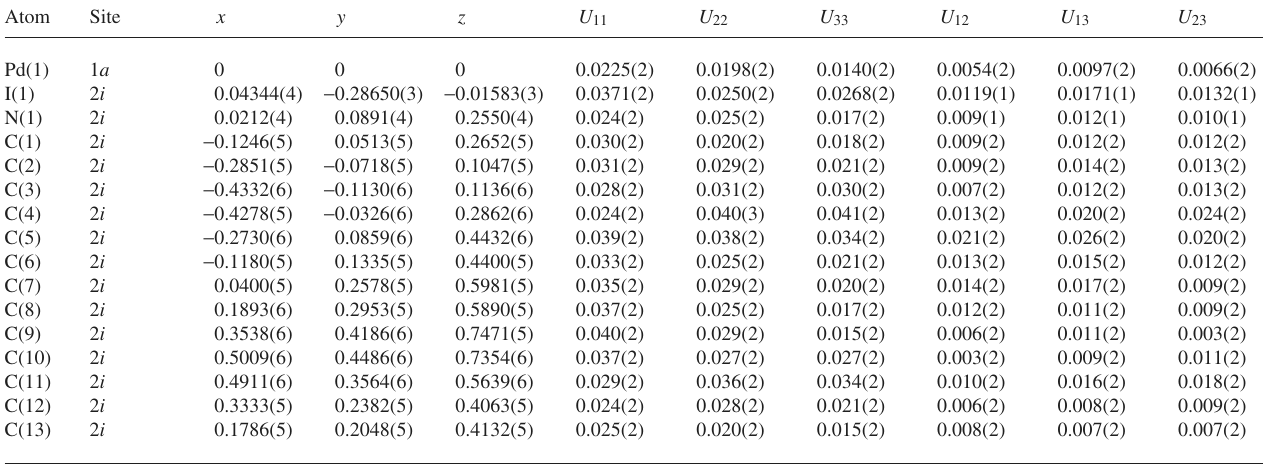
Table 3. Atomic coordinates and displacement parameters (in Å 2 ) .